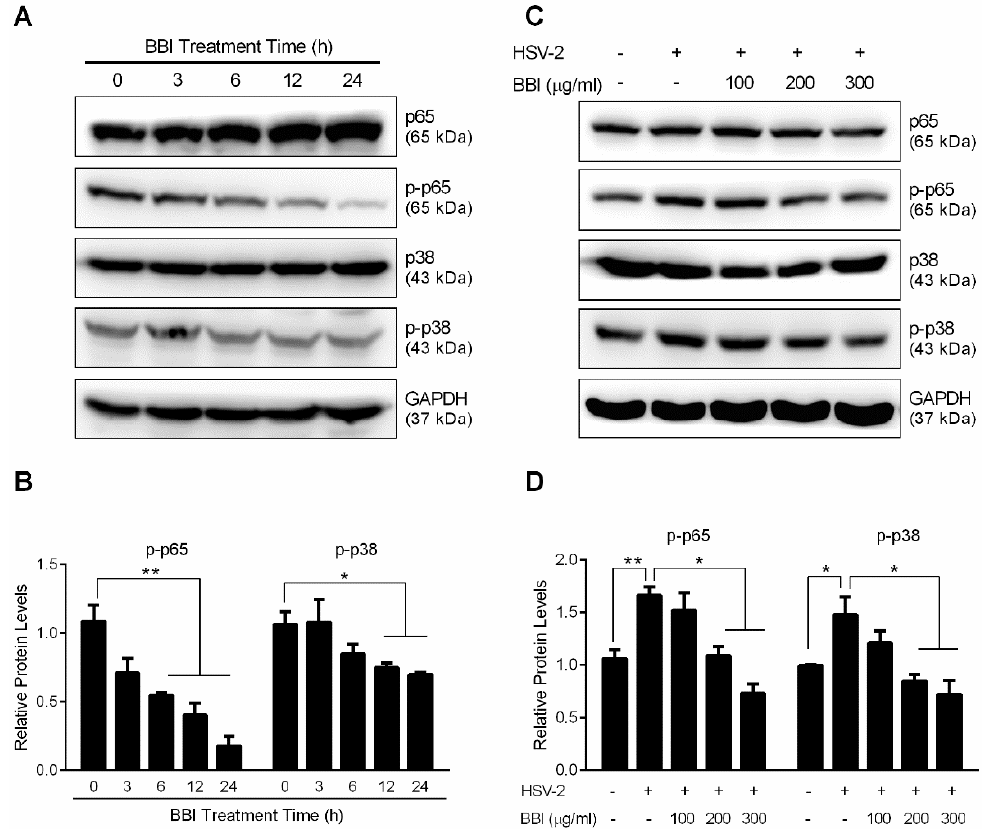
Figure 6. Effect of BBI on HSV-2-induced NF- κ B and MAPK activation. ( A ) End1/E6E7 cells were treated with BBI (200 µ g/mL) for indicated times. ( C ) End1/E6E7 cells were infected with HSV-2 (MOI of 0.001) for 2 h, then cultured with BBI at indicated concentrations. Cellular proteins were extracted and subjected to Western blot assay. Representative data from three independent experiments were shown. ( B , D ) Densitometry analysis of the blots shown in A and C was performed with ImageJ 1.44 software. Data shown were obtained as mean ± SD from three independent experiments (* p < 0.05, ** p < 0.01).